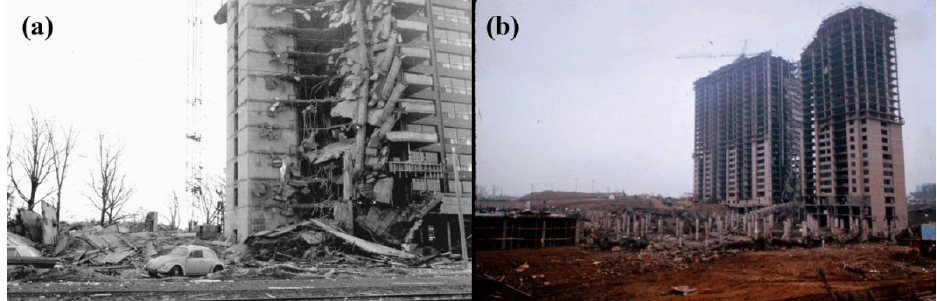
Figure 1. Collapse of slab-column structures: ( a ) a 16-storey apartment building, Boston [3]; ( b ) Skyline Plaza, Virginia [4].